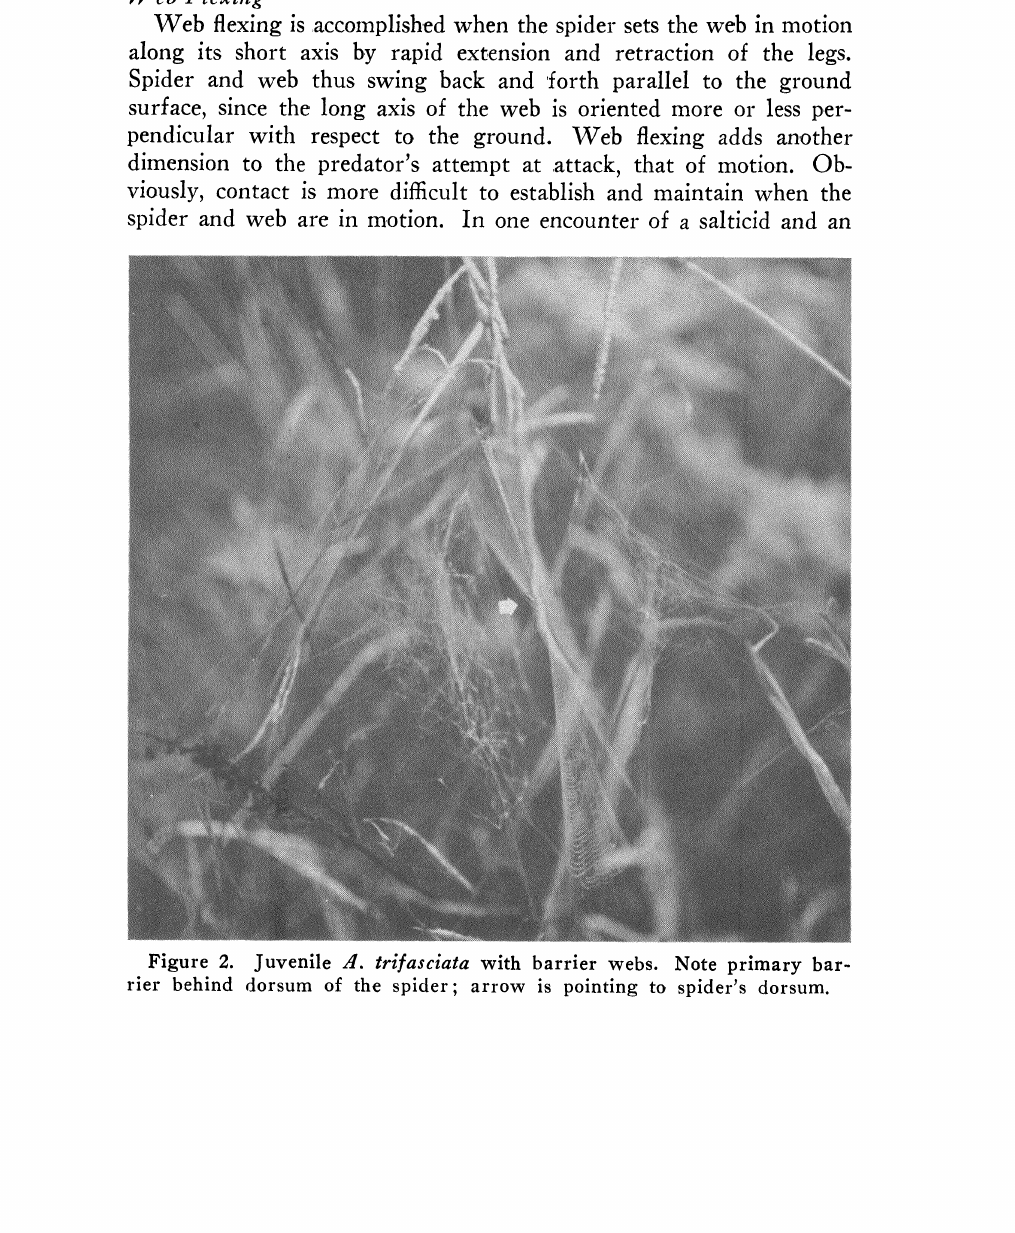
Figure 2. Juvenile At. tri[asciata with barrier webs. Note primary bar- rier behind dorsum of the spider; arrow is pointing to spider’s